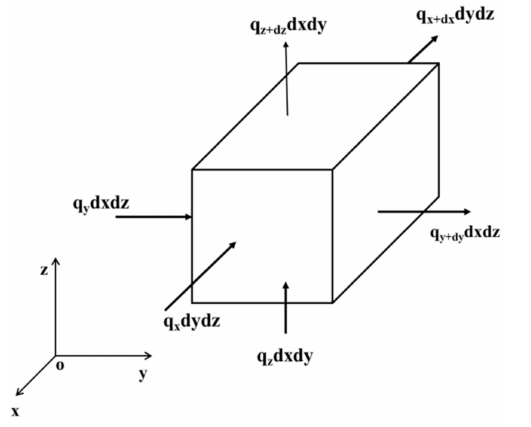
Figure 3. Energy conservation of a unit